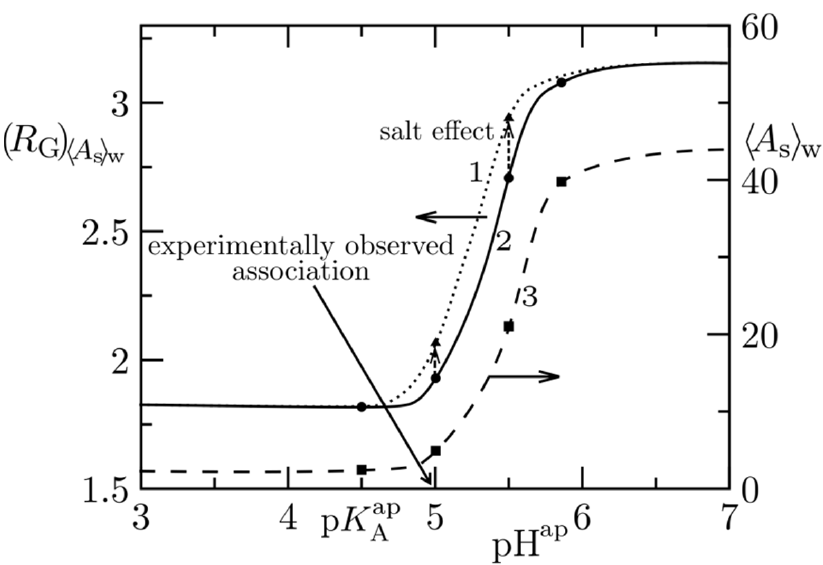
Figure 10. Weight average association number (cid:104) As (cid:105) W (dotted curve 3) and apparent radius of gyration, ( R G ) (cid:104) As (cid:105) w , (solid curve 2) as functions of pH ap . The effect of the salt is depicted by the shift in the radius of gyration for ionic strength I = 0.1and I = 0.25 (dotted curve 1). (Reprinted with permission from Macromolecules 2014 , 47 , 2503–2514, doi:10.1021/ma402293c. Copyright 2021 American Chemical Society).